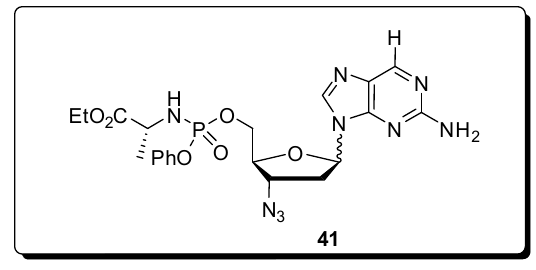
Figure 13. Chemical structure of the L-AZA prodrug 41 .